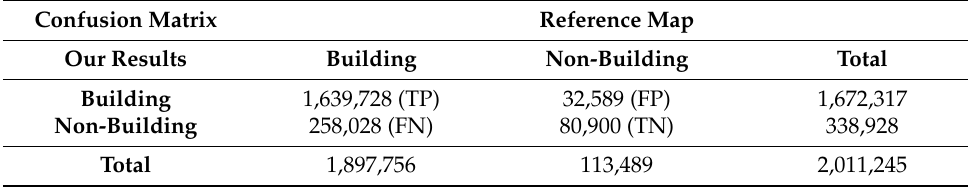
Table 4. Binary confusion matrix for 1970. Pixel-by-pixel comparison results.